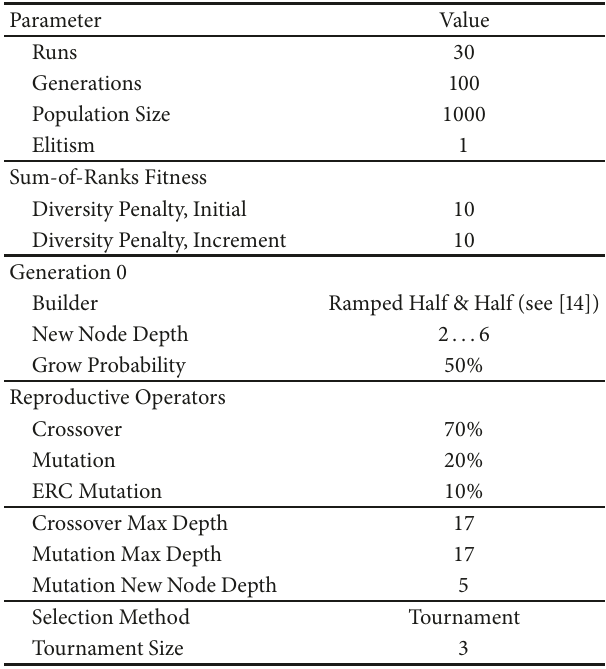
Table 1: Genetic programming engine parameters